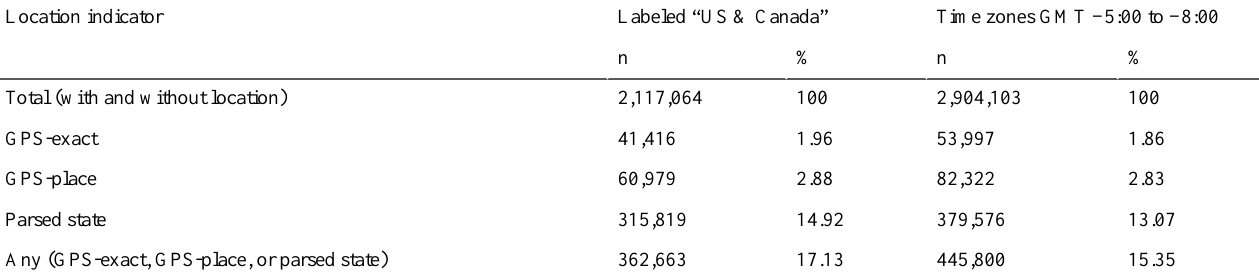
Table 2. Location of Twitter users within the time zones of the United